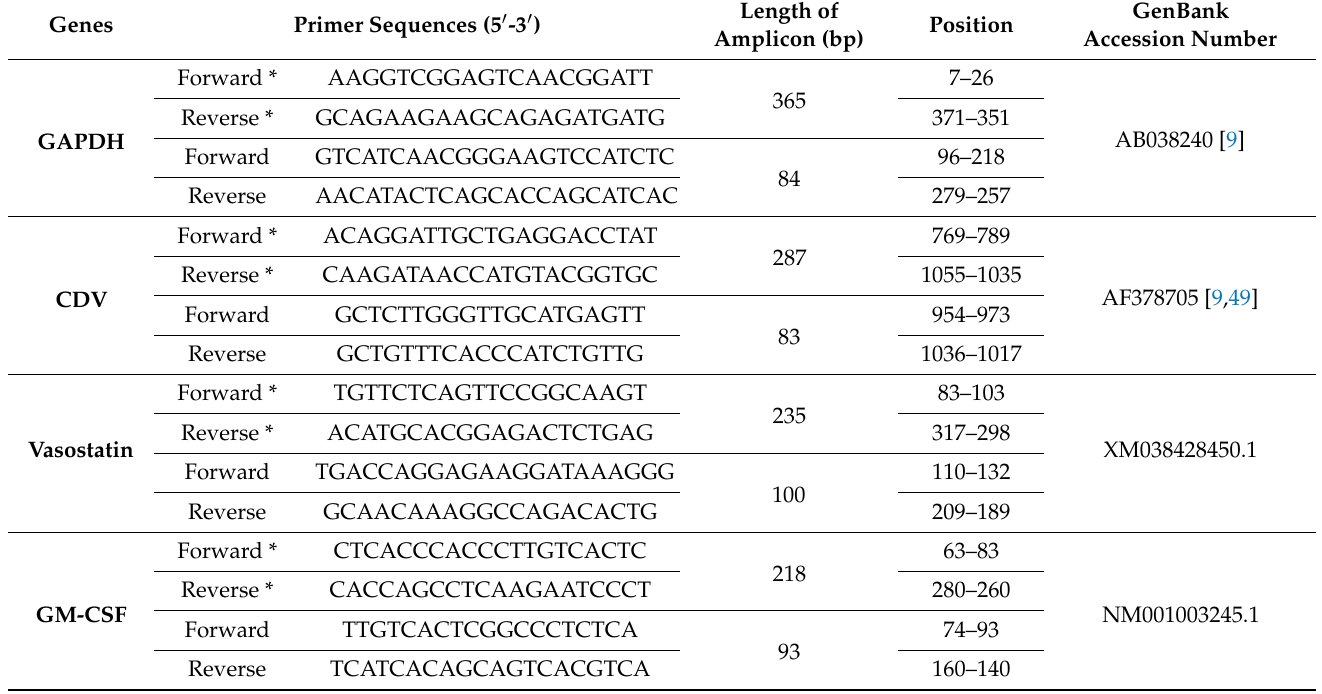
Table 6. Summary of primers used for qualitative and quantitative RT-PCR, expected amplicon length and GenBank accession